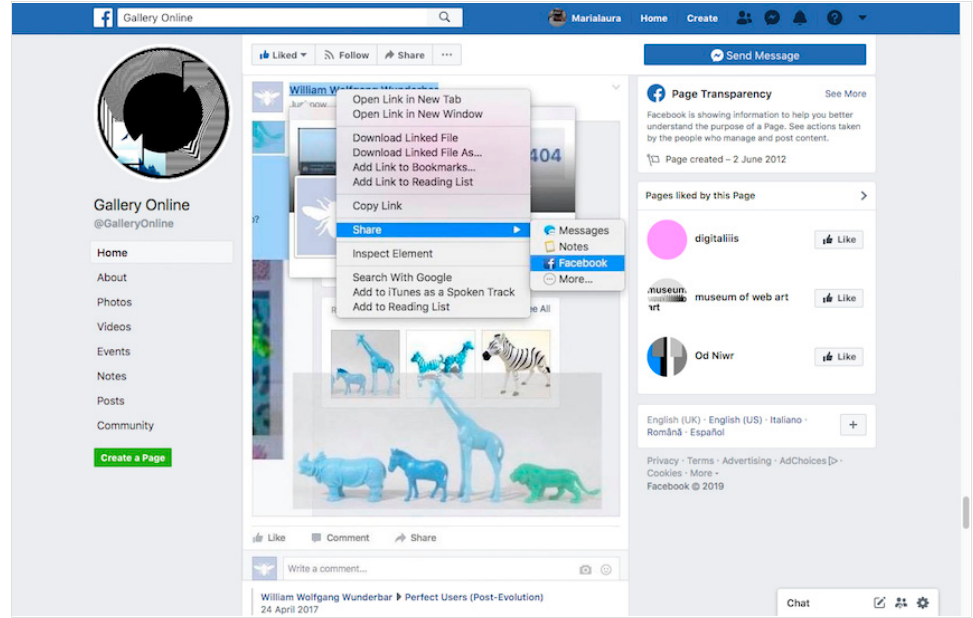
Figure 9. Gallery Online—William Wolfgang Wunderbar’s Joyfully mutating curiosity , 2012 (curated by Ronen Shai & Thomas Cheneseau). Screenshot of one of the artist’s posts on Facebook, 2019. © Gallery Online, 2019.